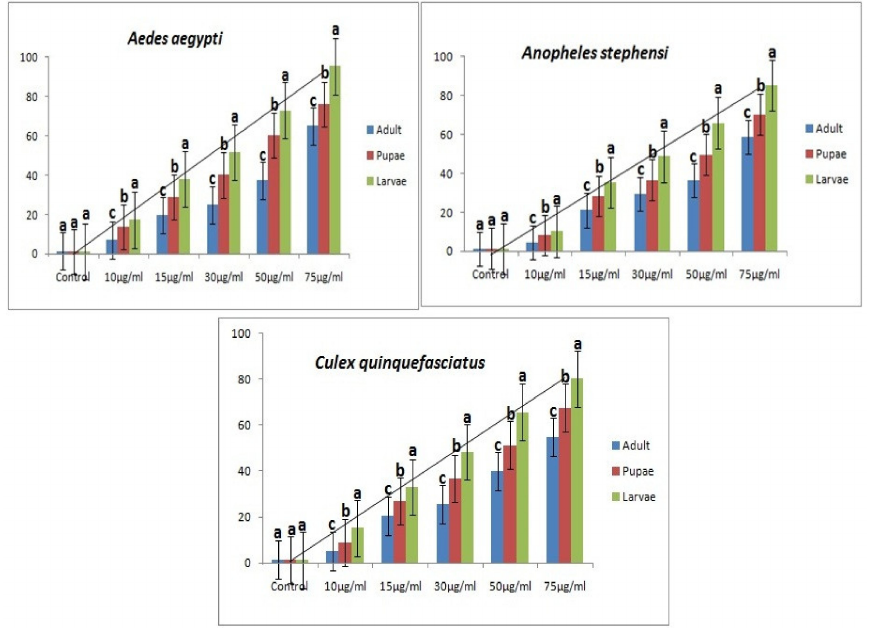
Figure 1. Larvicidal, pupicidal and adulticidal activities of M. anisopliae derived extract against larvae, pupae, and adult of Ae. aegypti , An. stephensi and Cx. quinquefasciatus vectors. Bars with the identical lower case letters do not differ significantly ( p >